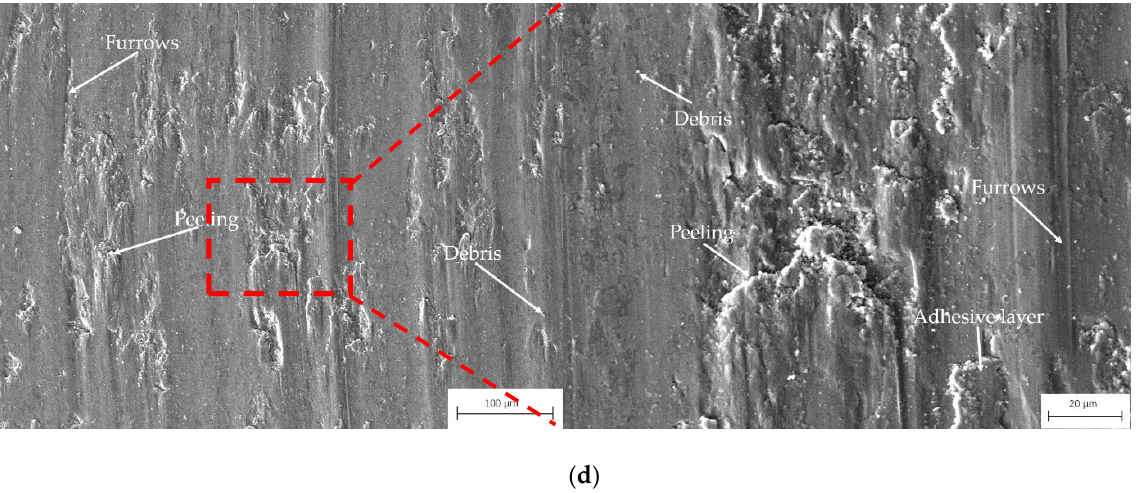
Figure 11. Wear morphologies of the CoCrFeNiMn HEA coatings after wear test at: ( a ) 50 A, ( b ) 55 A, ( c ) 60 A and ( d ) 65 A.